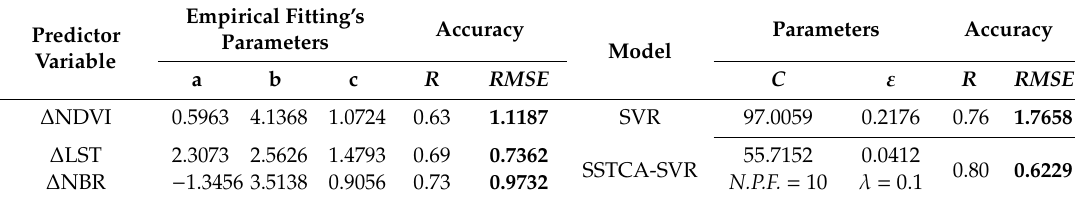
Table 3. Accuracies of mapped results across Bear Fire using di ff erent models.